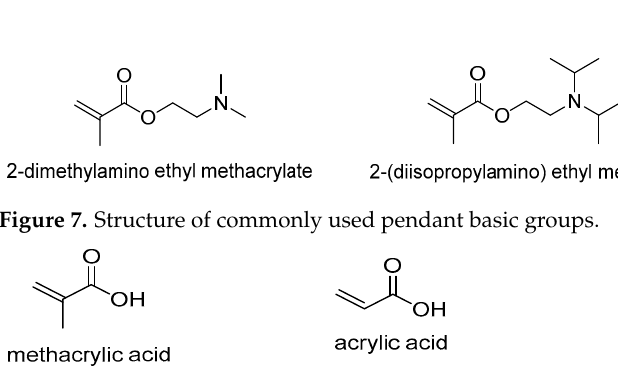
Figure 8. Structure of commonly used pendant acidic groups.